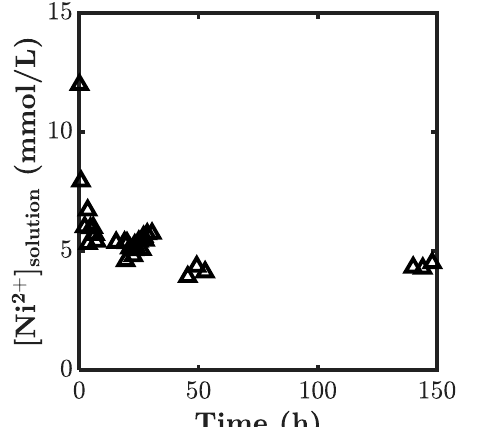
Figure 3. Decrease of Ni 2+ concentration in the solution due to uptake by a chemical gel as a function of time.